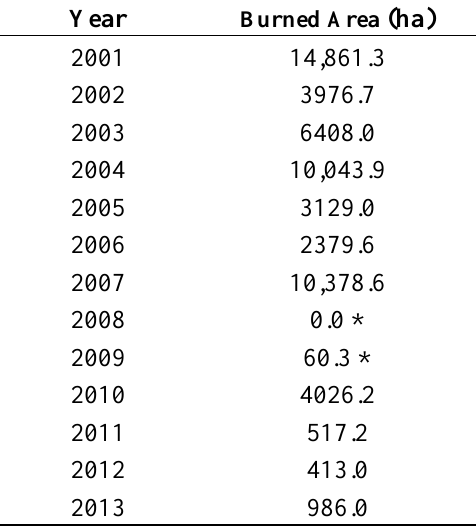
Figure 4. Location of the fire scars detected in the ‘ Complejo de Páramos’ of Cruz Verde-Sumapaz from January 2001–March 2003 through Landsat ( a ) and MODIS ( b ) imagery (background data: SRTM data V4). Table 2. Annual burned areas values (* Landsat imagery not